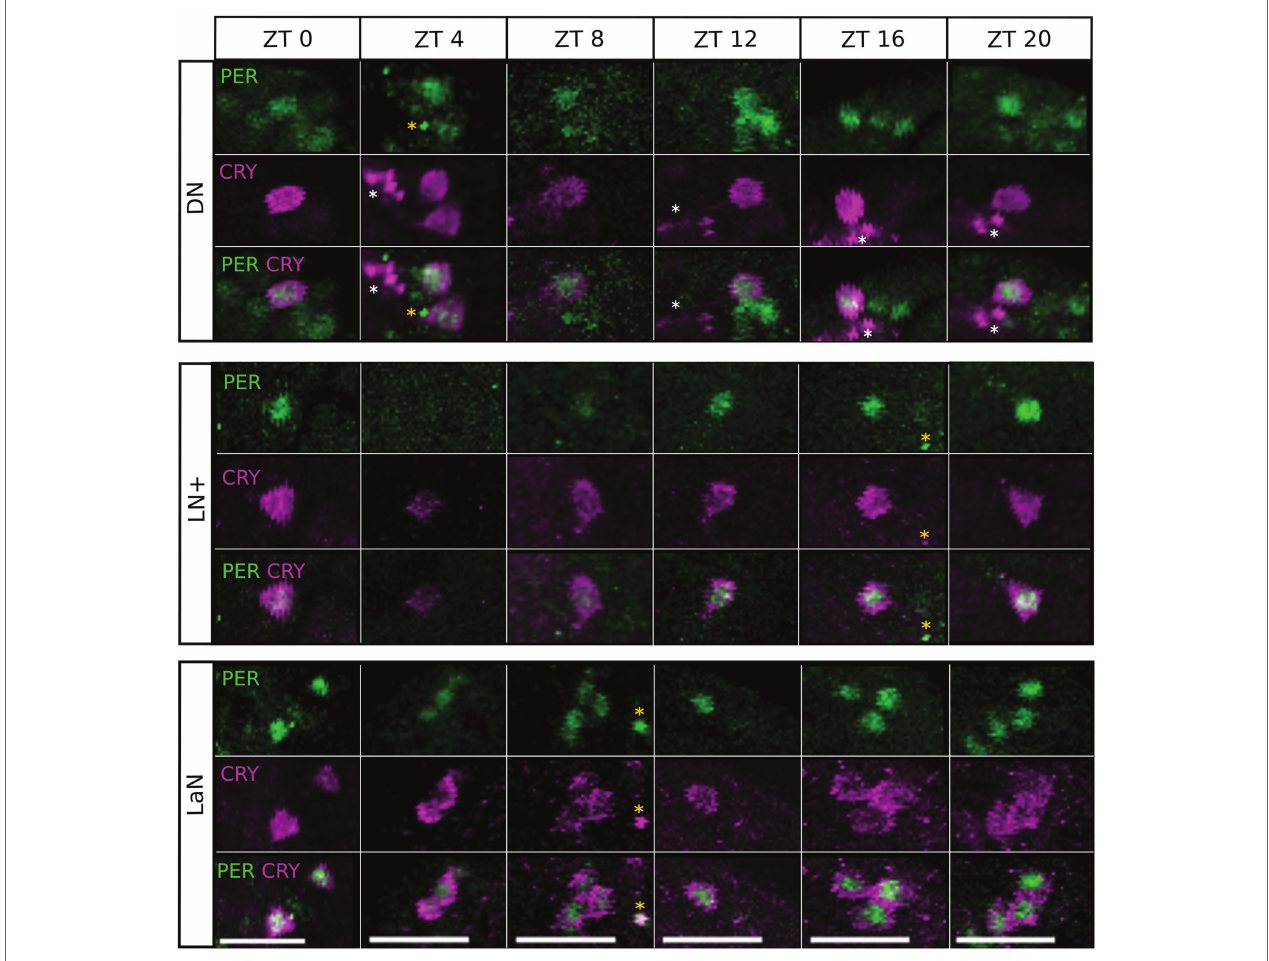
FIGURE 6 | Single stacks of co-immunostainings with anti-CRY and anti-PER at different time points. The location of PER and CRY remains similar in all time points and depends on the cluster. PER signal is mainly nuclear, with some labeling in the region surrounding the nucleus. In the LaN, CRY signal is mainly cytoplasmic while in the DN and LN+, it partially localizes also in the nucleus. White asterisks: CRY arborizations. Orange asterisk: unspecific signal. Scale bar: 20 μ